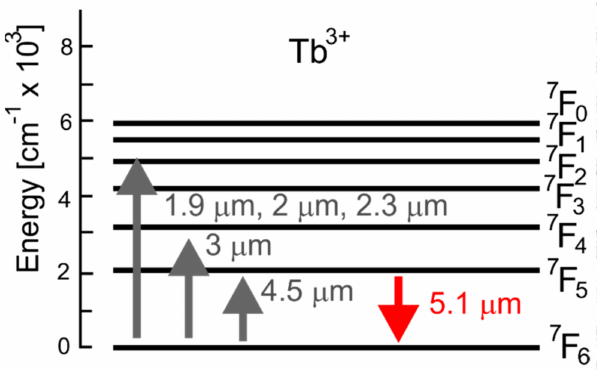
Figure 3. Energy level diagram for a terbium ion doped into selenide chalcogenide glass.